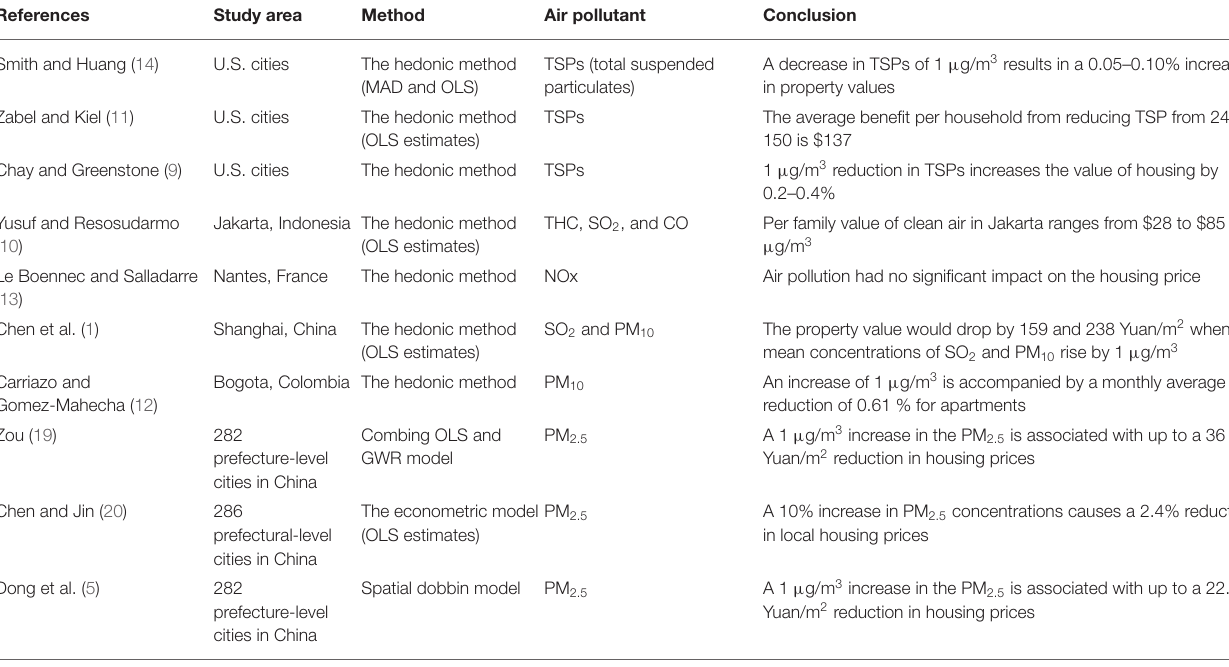
TABLE 1 | Research about the impact of air pollution on the real estate